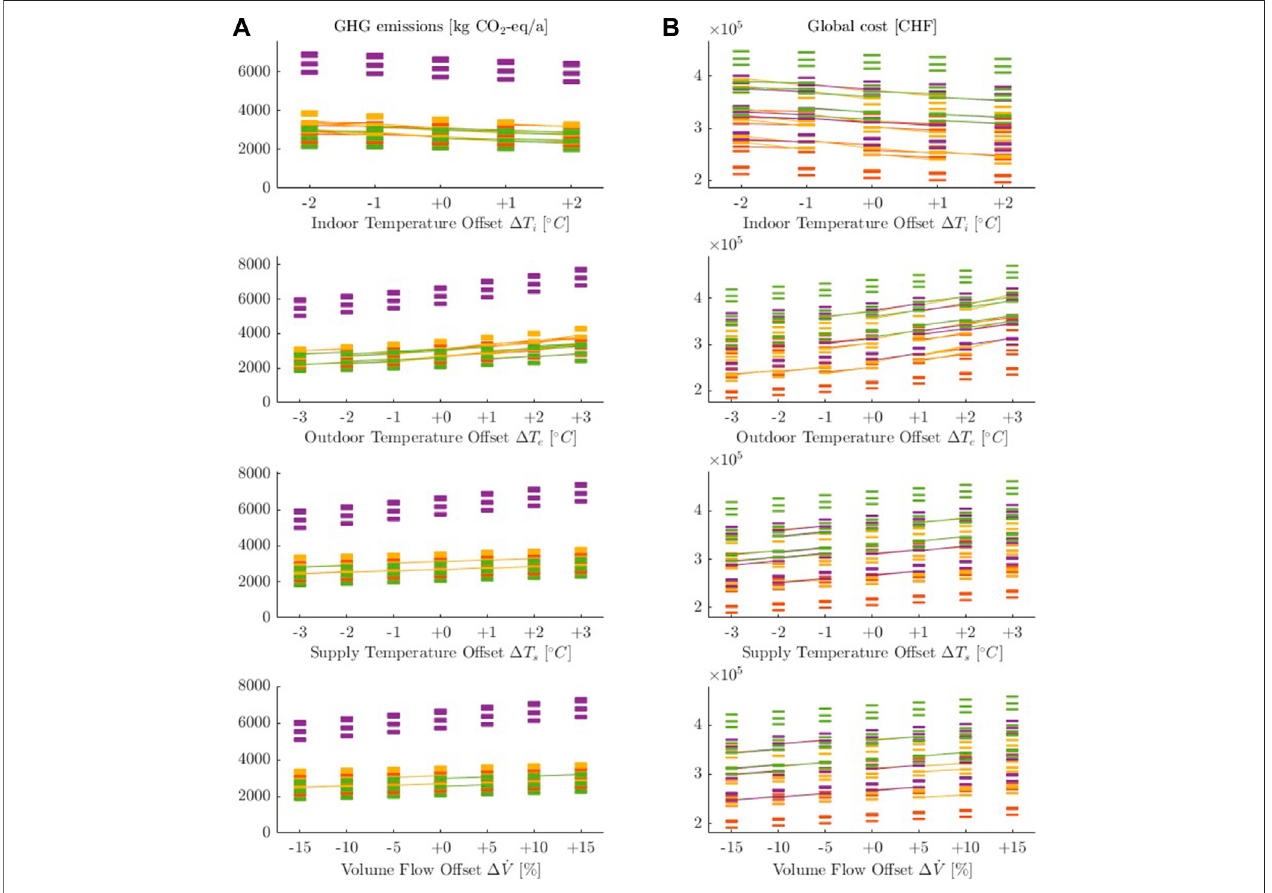
FIGURE7| Measurement uncertainty impactsfromvarious measurement uncertaintiesontherankofpredicted performanceofretro fi tmeasures, (A) greenhouse gas emissions, (B) global cost, red: geothermal heat pump, yellow: air-to-water heat pump, purple: district heating, green: pellet boiler. All plots show that the spacing between the retro fi t measures combinations remains similar throughout out the input variation and the changes in ranks are rare and are limited to one or two positions.